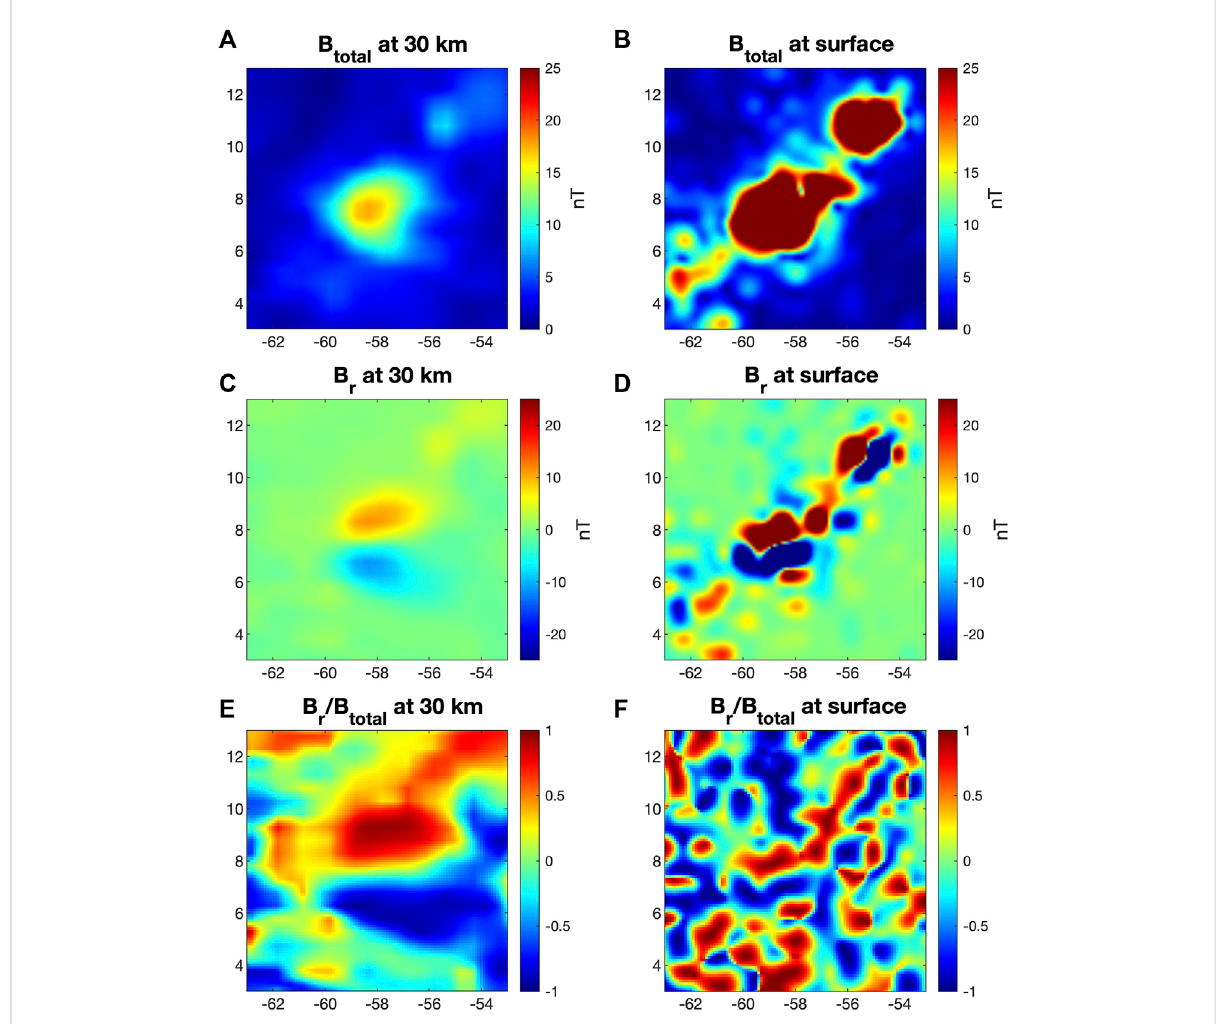
FIGURE 5 Comparison of RG-associated magnetic fi elds modeled at LP average orbital height of 30 km (left column) and at the lunar surface (right column). The top row (A,B) visualizes the total fi eld magnitude, B total , which contains no directional information. The middle row (C,D) visualizes the radialcomponent,B r ,whichindicates fi elddirectionandintensityintooroutofthepage.Thebottomrow (E,F) visualizesB r /B total whichcontainsonly directional information ( + 1 out of the page and − 1 into the page), to elucidate fi eld structure visible in surface models compared to 30 km